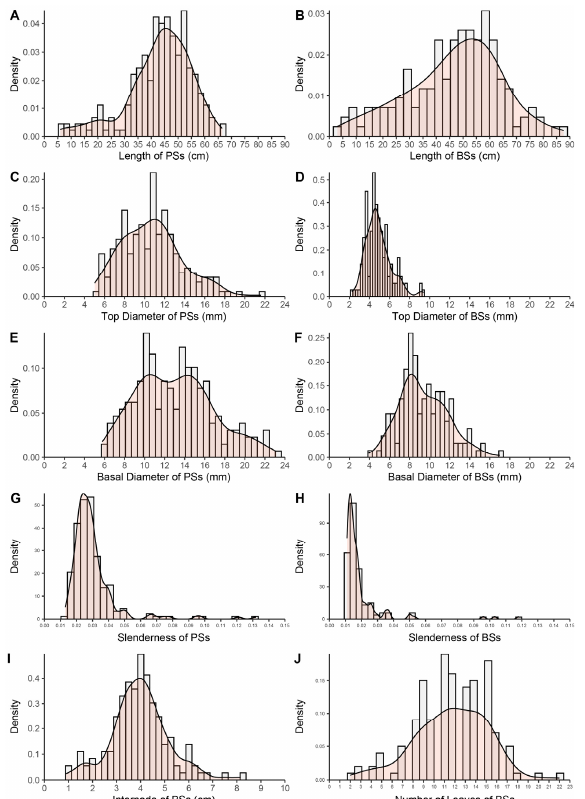
Figure 5. Exponential distribution of the trait values for the “Yuanhua” Sapindus mukorossi parent shoots (PSs) and bearing shoots (BSs). ( A ) the density of the length of PSs; ( B ) the density of the length of BSs; ( C ) the density of the top diameter of PSs; ( D ) the density of the top diameter of BSs; ( E ) the density of the basal diameter of PSs; ( F ) the density of the basal diameter of BSs; ( G ) the density of the slenderness of PSs; ( H ) the density of the slenderness of BSs; ( I ) the density of the internode of BSs; ( J ) the density of the number of leaves of BSs.